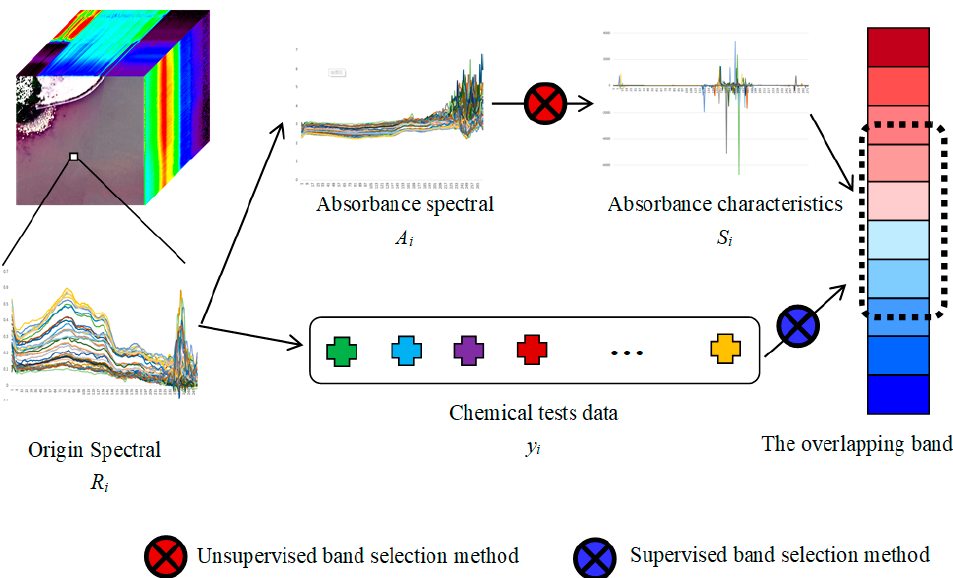
Figure 5. The flow of a recognition algorithm of absorbance characteristics. The characteristic bands selected by supervised method and unsupervised method are obtained through direct and indirect methods, and the overlapping bands are used as the influential bands.